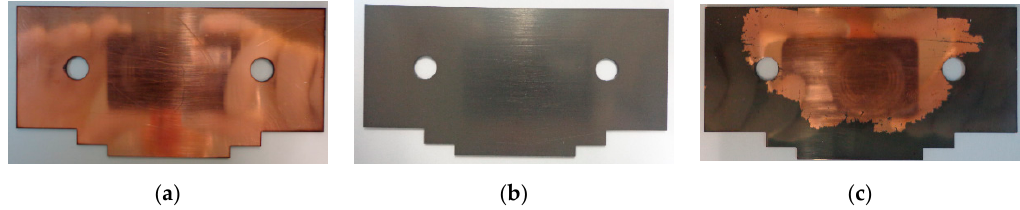
Figure 4. Diamond-like carbon (DLC) coating before and after failure. ( a ) Uncoated side before failure, ( b ) Coated side before failure, ( c ) Coated side after failure (4.5 weeks).